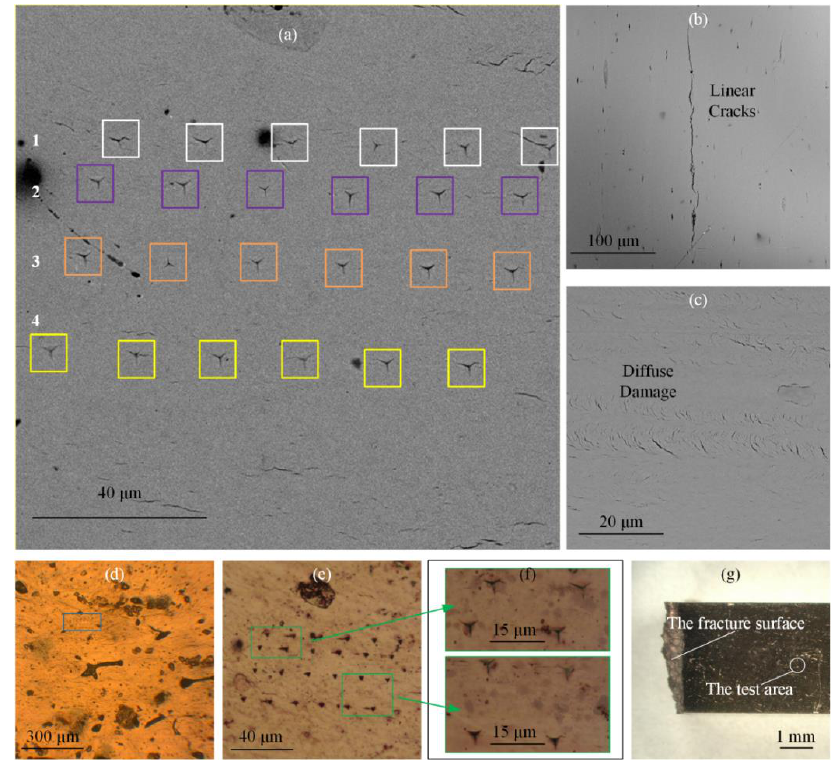
Figure 3. The residual indentations and fatigue damage under optical microscope and SEM. ( a ) SEM image of the indentations; ( b ) Linear cracks; ( c ) Diffuse damage; ( d – f ) Optical microscope images of the indentations; ( g ) The fracture surface and the test area. Compared with the damage due to fatigue loading, the damage caused by indentations could be